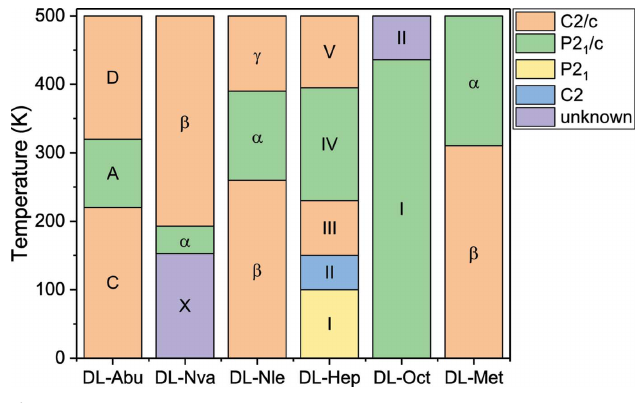
Figure 2 Schematic of the enantiotropically related polymorphs of linear amino acid racemates and their stability temperature interval; space group symmetries are indicated.